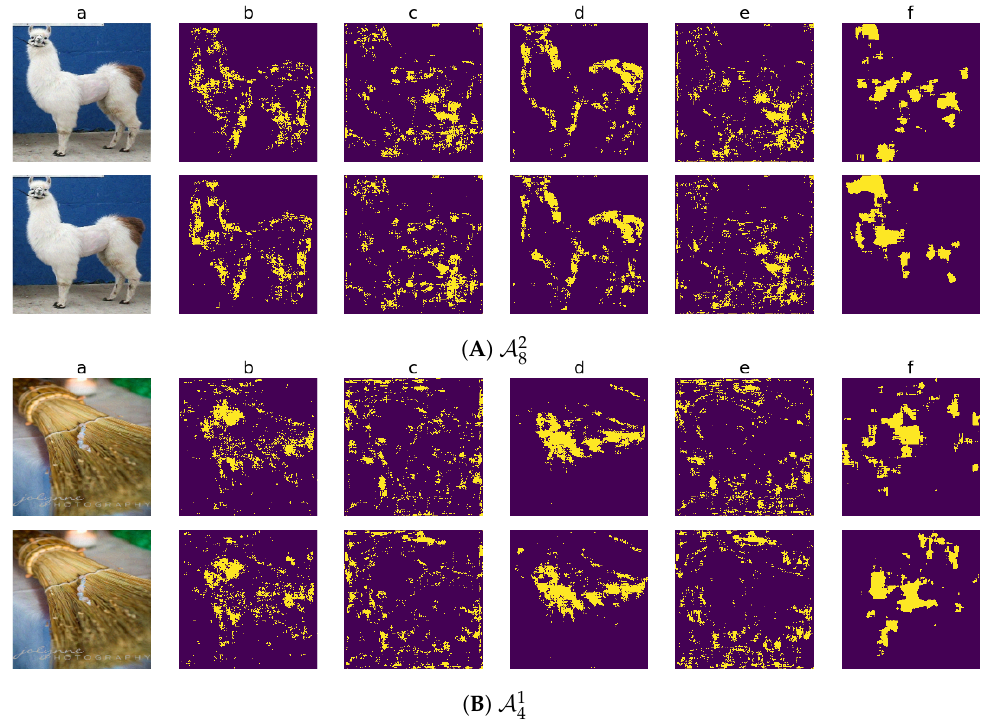
( A 2 ) ( A ) and Figure A5. Heatmaps obtained with the ancestor A 2 and the adversarial images D atk 8 8 6 ( A 1 ) ( B ). In each pair of rows, atk = EA in the with the ancestor A 1 and the adversarial images D atk 6 4 4 first row and atk = BIM in the second. In columns b through e of ( A , B ), the heat maps are created using BagNet-17 and represent the following: 10% smallest values of c a ( P ( D ( A ))) − c a ( P ( A )) (b); 10% largest values of c t ( P ( D ( A ))) − c t ( P ( A )) (c); 10% largest values of c a ( P ( D ( A ))) − c t ( P ( D ( A ))) (d); 10% largest values of c t ( P ( D ( A ))) − c a ( P ( D ( A ))) (e). Heatmap (f) is obtained with C k and represents the 10% largest values of c t ( IP ( D ( A ))) − c t ( A )